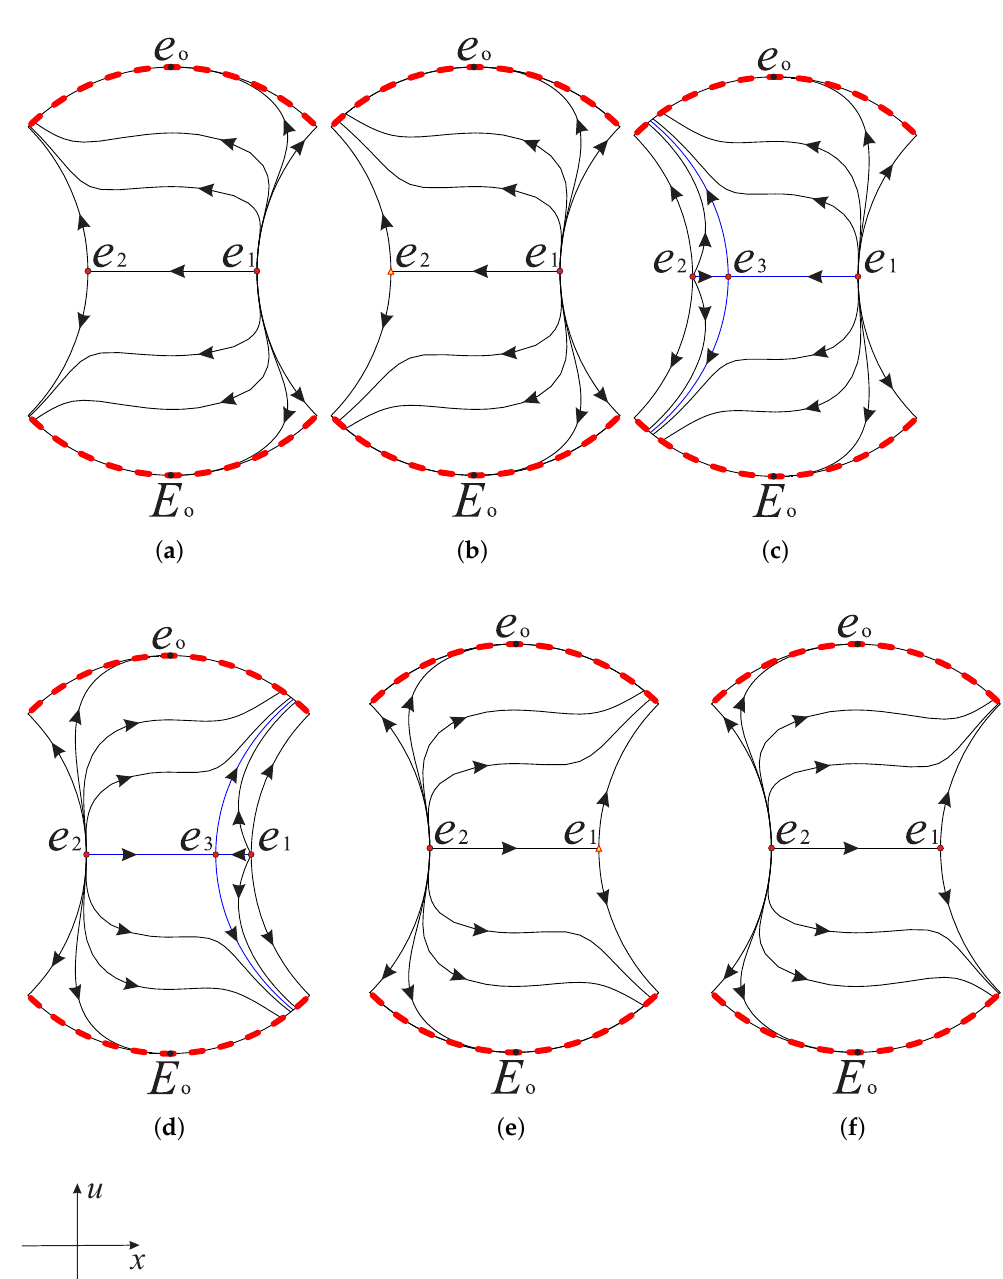
Figure 2. The phase portrait on the invariant plane z = 0 of system (8) restricted to the region x 2 − u 2 ≤ 1 inside the Poincaré disc for different values of s : ( a ) s < −√ ( c ) 6/2 < s < 0, ( d ) 0 < s < opposite equilibrium point of e o at